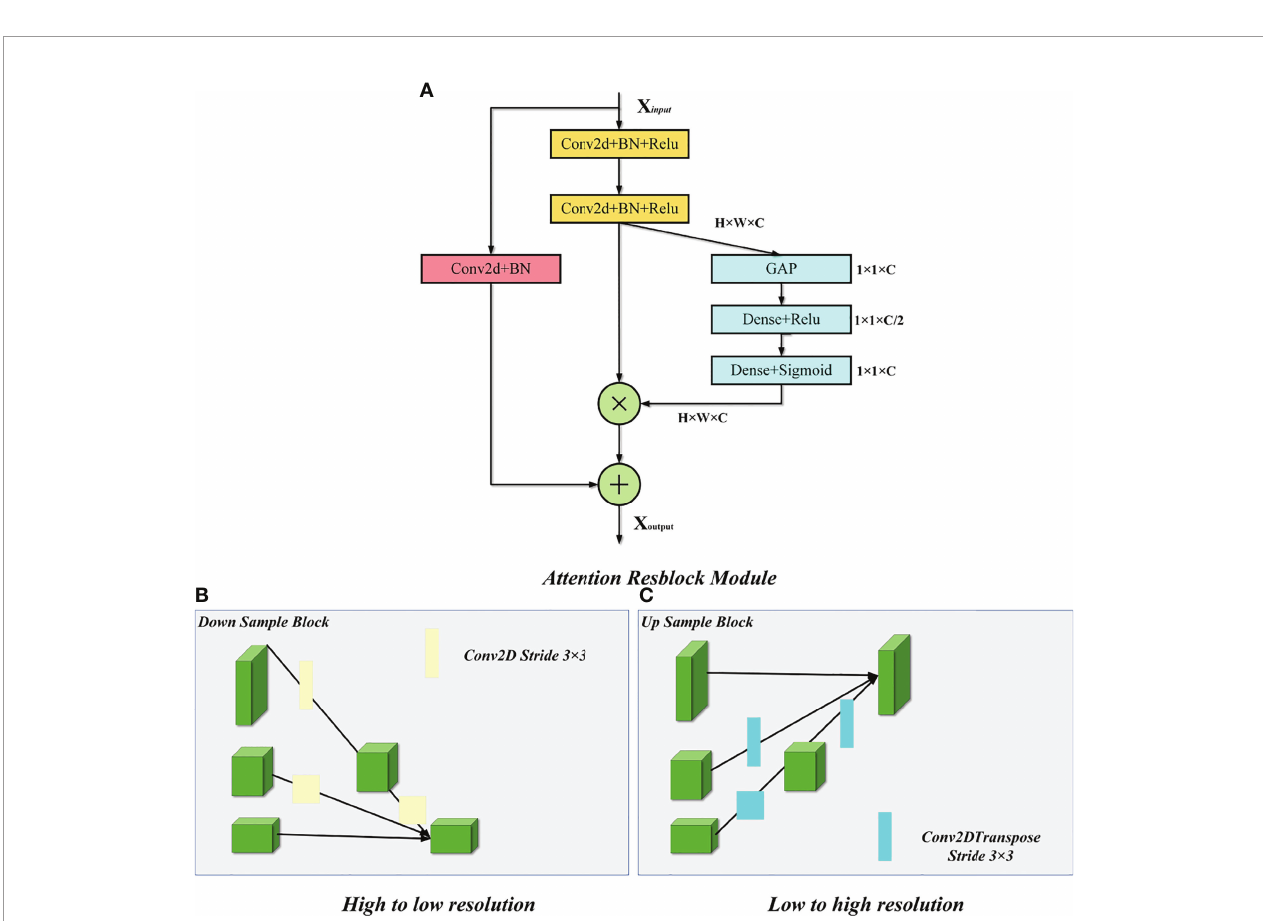
FIGURE 3 | Attention Resblock Module and feature fusion of different scales. (A) Attention Resblock Module; blue cuboid = cSE module, red cuboid = Resblock module. (B) One or more stride convolutions (3 × 3) were used in the conversion from high to low resolution. (C) One or more transposed convolutions (3 × 3) were used in the conversion from low to high